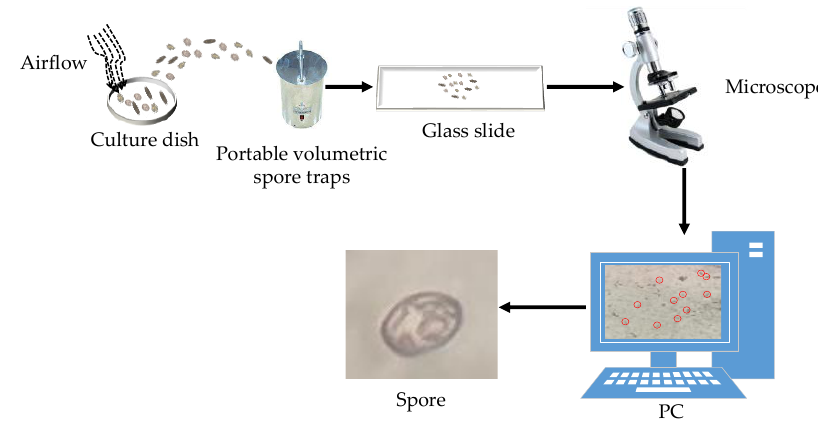
Figure 2. Spore image collection.